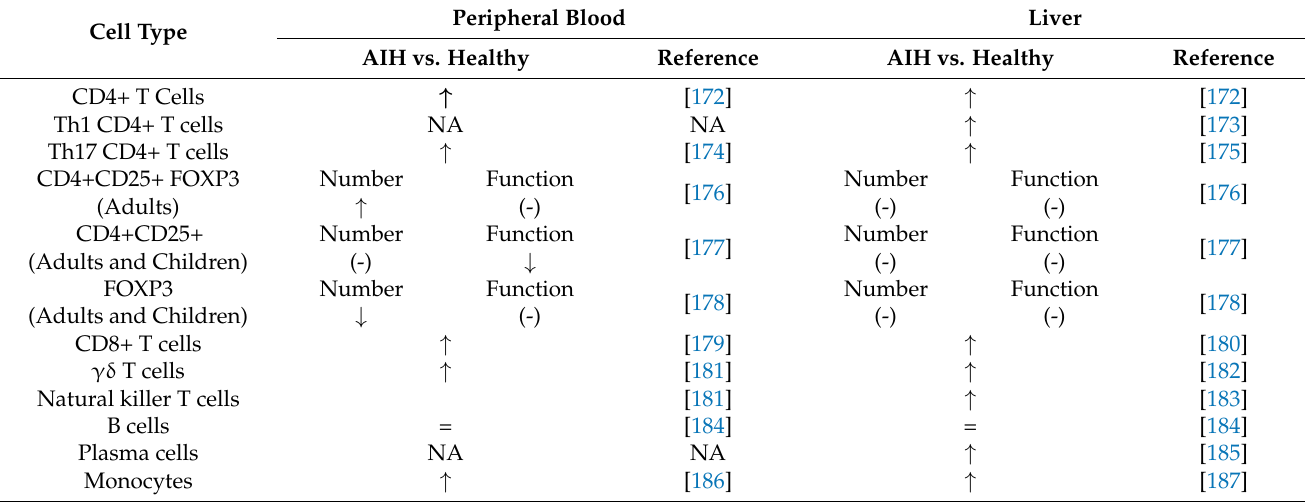
Table 3. Cellular mechanisms in autoimmune hepatitis.